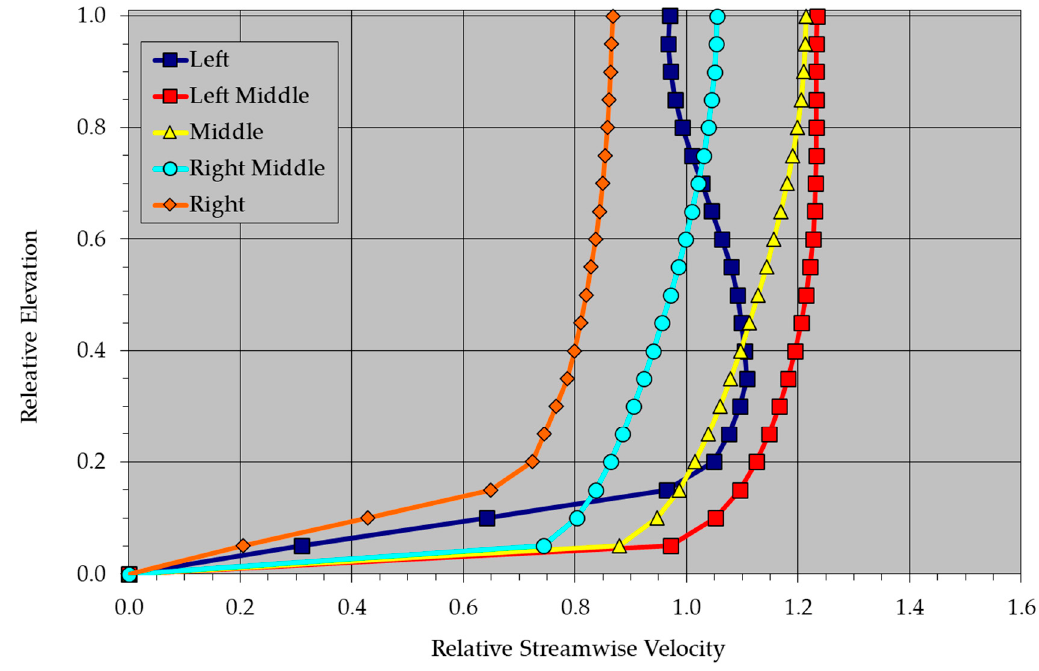
Figure 40. Vertical streamwise velocity profiles at Cross-section 950 (4th meander bend) for Simulation Set 5 with a sinuosity of 2.75.